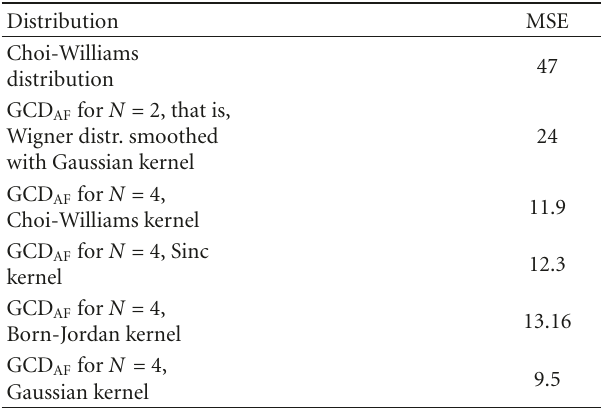
Table 2: MSE of the IF estimation.